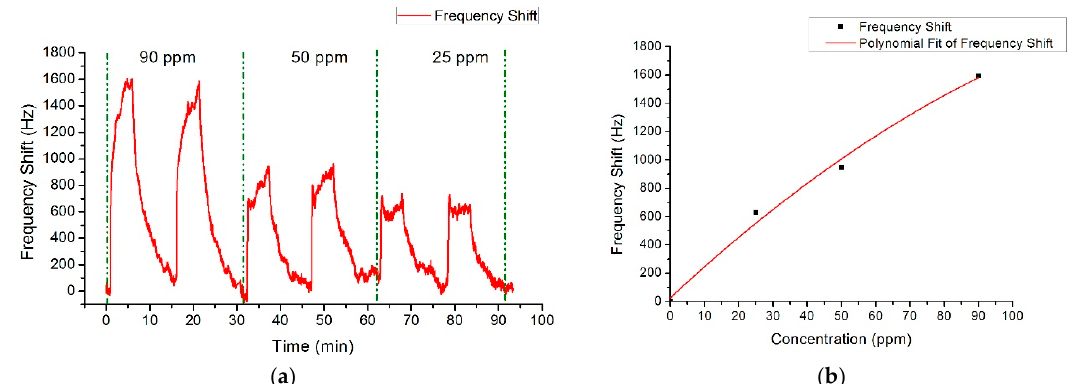
Figure 4. Ammonia characterization. ( a ) Dynamic response of sensor to different concentrations of ammonia; ( b ) Response of sensor as a function of ammonia